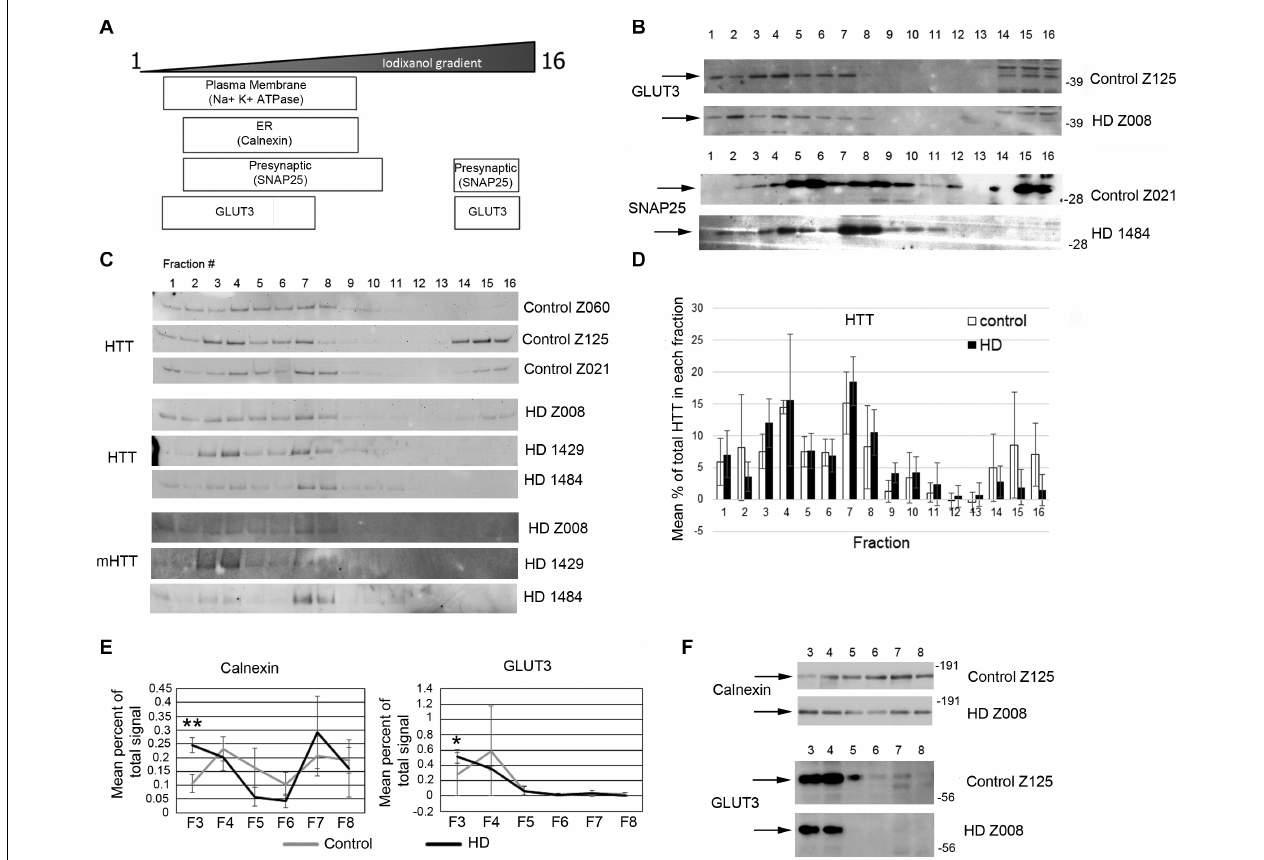
FIGURE 7 | Subcellular fractionation by density gradient ultracentrifugation of human putamen. Dorsal putamen was fractionated as described in section “Materials and Methods.” Fractions were assessed by SDS-PAGE and western blot analysis using different cell compartment markers. Fractions 1–16 were removed from top to bottom. Equal volumes of each fraction were loaded per lane. (A) Diagram at left shows approximate distribution of proteins representative of different subcellular compartments in the control putamen. (B) Shown are representative images of western blots detecting GLUT3 and SNAP25 in control and HD putamen. (C) Shown are WB images of Huntingtin (HTT) and mutant HTT (mHTT) signals in 16 fractions from all human putamen samples. mHTT was detected with 1C2 which recognizes the expanded polyQ region in mutant HTT but not HTT in control samples. (D) Bar graph shows mean percent ± SD of HTT signal obtained with antibody Ab1 in control and HD human putamen in each of 16 fractions as a percent of total HTT signal summed across all fractions. There was no significant difference in HTT signal between control and HD in any of the fractions ( N = 3). (E) Fractions 3–8 were analyzed in pairs and run on the same gel to eliminate variability due to different runs. These fractions were chosen because most proteins tested had peaks in this range. Seven probes were analyzed by western blot for each gel (Calnexin, GLUT3, Na+/K+ ATPase, NMDAR 2b, PSD95, SNAP25, and XK). Band intensity for each fraction was standardized to sum of intensities for bands in fractions 3–8. Line graphs show mean percent of total signal ± SD obtained in fractions 3–8 for each fraction ( N = 3). There was a significant difference in percent of total signal in fractions 3–8 in fraction 3 for Calnexin (** p = 0.0052, N = 3, unpaired t -test for all analyses) and GLUT3 (* p = 0.047). (F) Representative images of western blots for Calnexin and GLUT3 in control and HD putamen related to the data shown. See Supplementary Figure 5 for other line graphs.